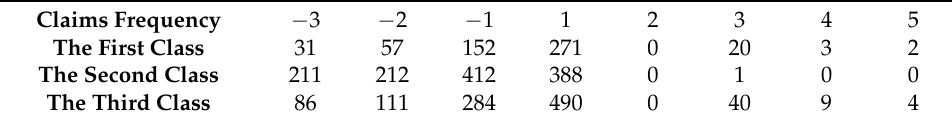
Table 3. Distribution of claim frequency in three classes.